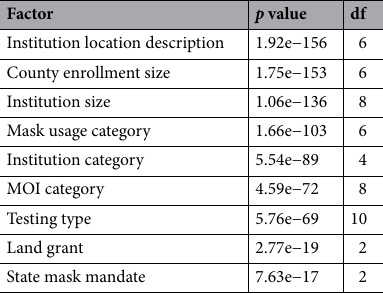
Table 4. Overall chi-square results for hierarchical cluster analysis factors contributing to county-level population adjusted COVID-19 cases in fall 2020 (September 1st–December